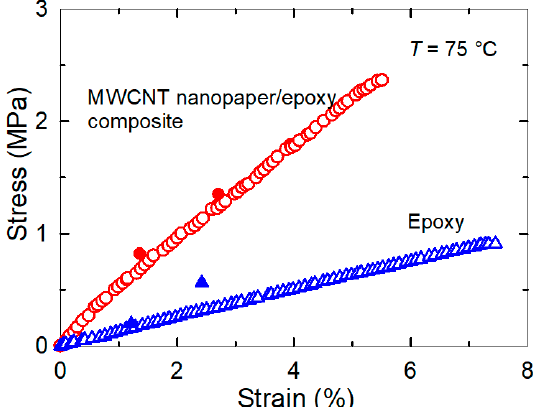
Figure 4. Comparison of the recovered stress after the reheating of the MWCNT nanopaper/epoxy composite (red filled circles) and the epoxy (blue filled triangles) strips to the temperature of 75 °C together with the results of the tensile test performed at the same conditions from Figure 3.